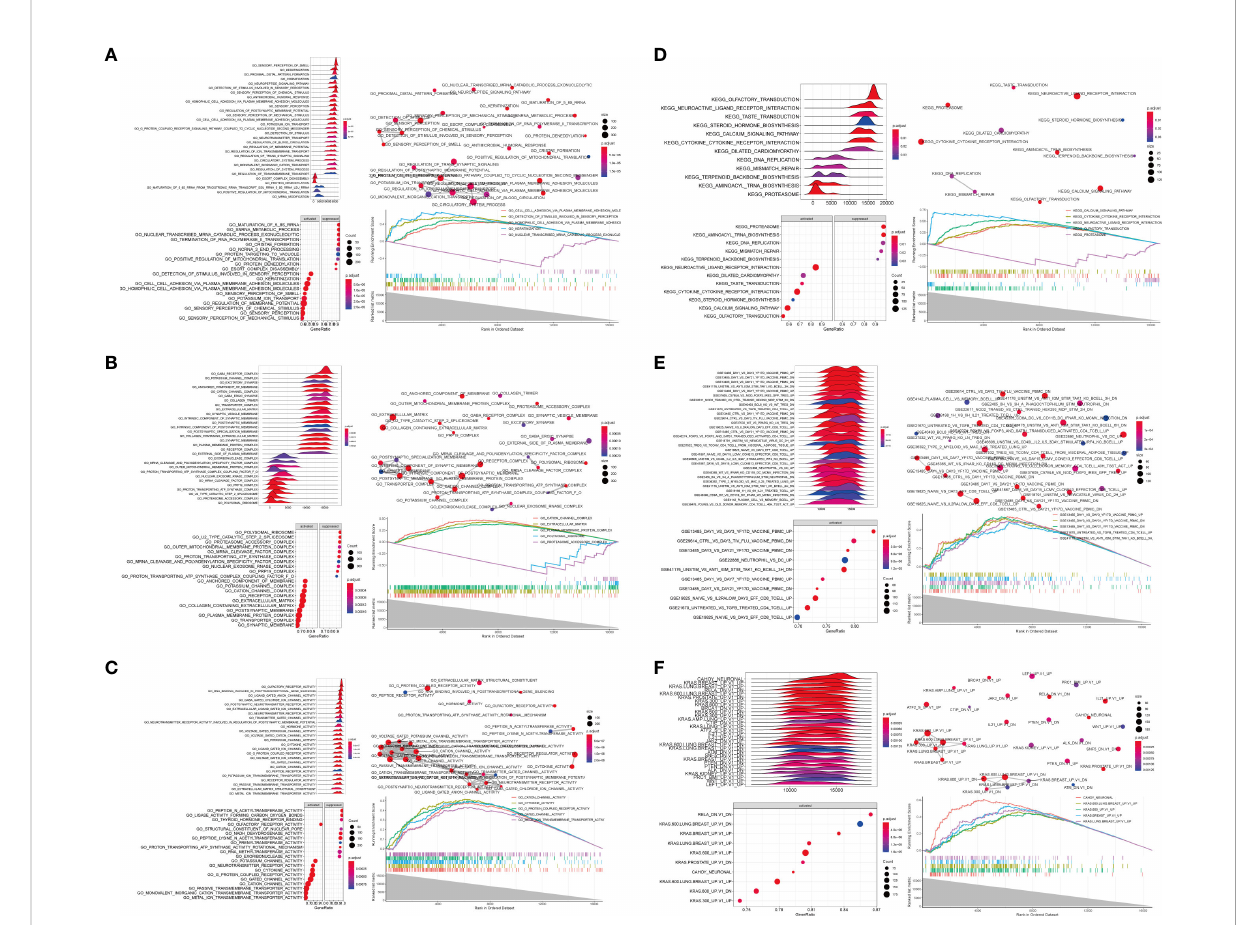
FIGURE 5 GSEA of differentially expressed genes (DEGs) related to TRAF3IP3. (A – C) TRAF3IP3-related DEGs are mainly enriched in terms in KEGG/BP/CC/ MF/oncogenic/immunologic, the relationship between each term, and the activation or inhibition of genes in term. (D – F) GSEA of DEGs related to